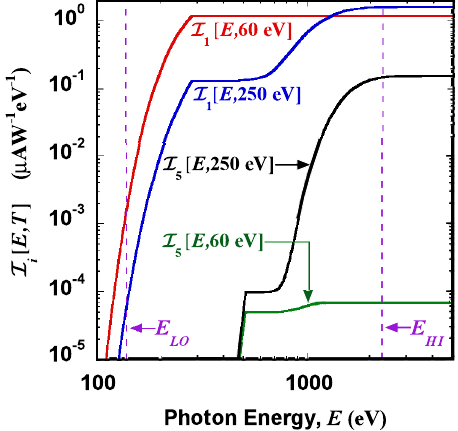
(cid:7) (cf. Fig. 5): MAX ð E; T Þ is the nor- bb